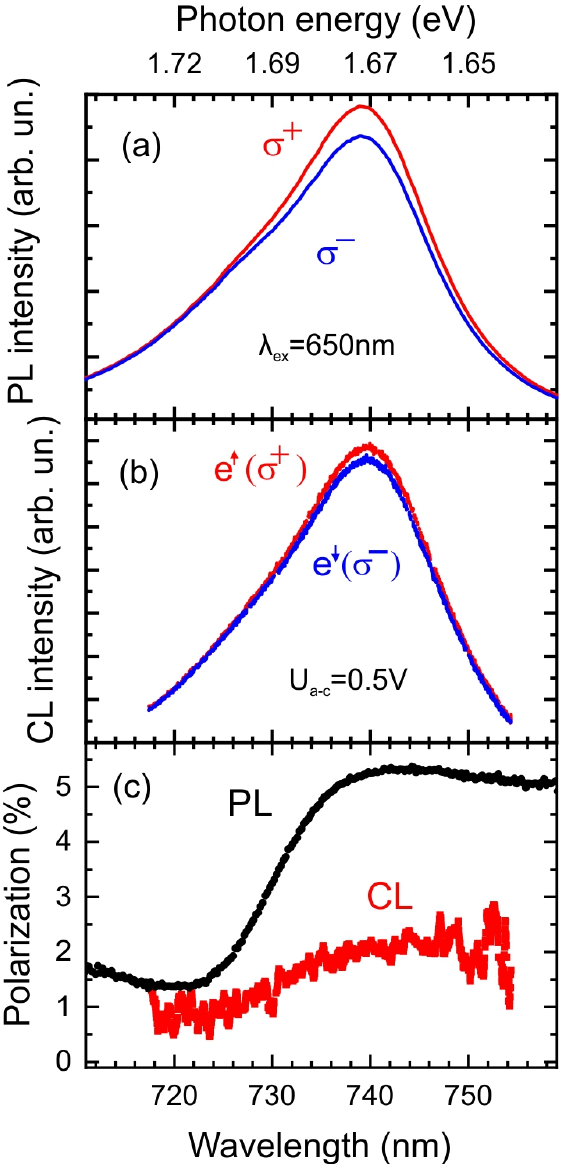
Figure 5. ( a ) PL circularly polarized components ( σ +, σ − ) spectrum of GaAs/Al x Ga 1 − x As QWs excited by the CP emission of laser diode (650 nm). ( b ) CP components ( σ +, σ − ) of the CL spectra from injected spin-polarized electrons at the accelerating voltage of 0.5 V at 300 K. ( c ) The CP degree of the PL and CL emission at room temperature. An important characteristic for spin polarimetry is the spin selectivity, where S repre- sents the Sherman function, defined as the spin asymmetry for a 100% polarized electron beam. The detected P CL in the studied QWs was 2% with the injection of a 20–25% spin- polarized electron beam [23], which provides an asymmetry (Sherman function) equal to S CL = P CL /P 0 =